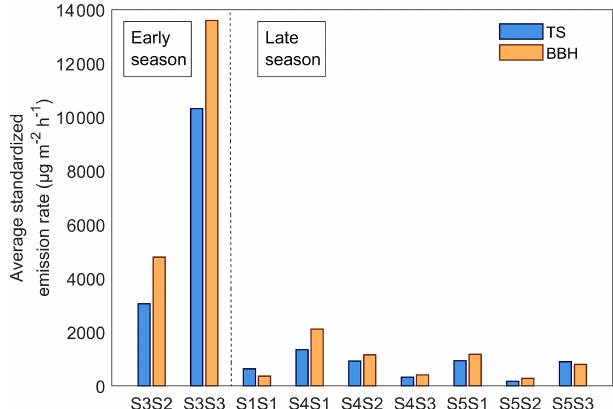
Figure 7. The seasonal average temperature standardized emission rate for all BVOCs combined from all infested Norway spruce trees located in Hyltemossa and Norunda. The tree ID is presented on the x axis and is separated into early and late season ( < 100 or > 100d since infestation start respectively). The temperature standardized (TS) emission rates are presented in blue, while the emission rates scaled by the average number of bark beetle holes (BBHs) is pre- sented in